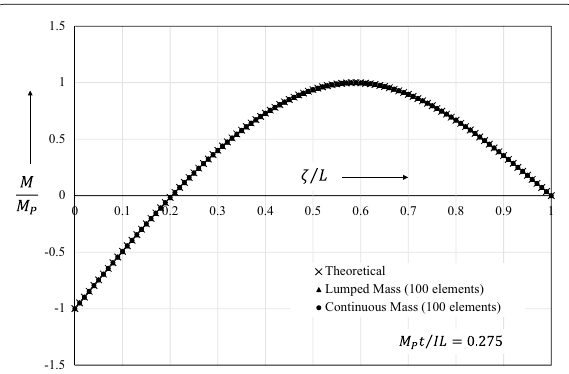
Fig. 10 Dynamic bending moment when the pulse terminates ( P 0 = 2.5 P c )